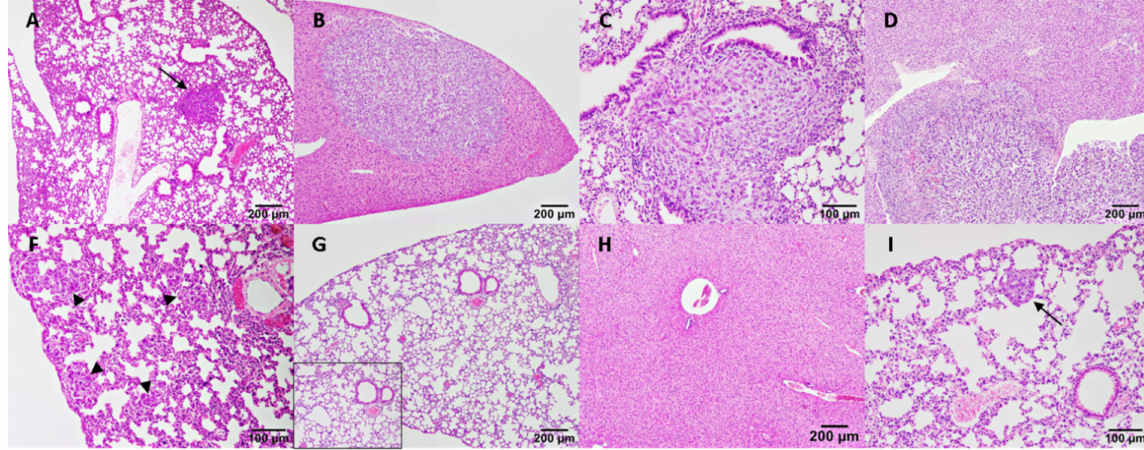
Figure 7. Metastatic foci in lungs and liver after VEGF, SU5416, bevacizumab and celecoxib treatment in IPC-366 and SUM149 xenotransplanted mice. ( A ) SUM149 control mice lung with metastatic focus. ( B ) IPC-336 control mice liver with large metastic focus. ( C , D ). Foci of metastases in lung and liver after VEGF inoculation in IPC-366- (c) and SUM149- (d) xenotransplanted mice. ( F ) Multiple small foci of metastasis in the lung of SUM-149 mice treated with 5 mg/kg of SU5416. ( G , H ). Absence of metastatic foci after bevacizumab treatment in IPC-366 xenografted mice. ( I ) Small foci of metastasis after inoculation (0.5 mg/kg) of